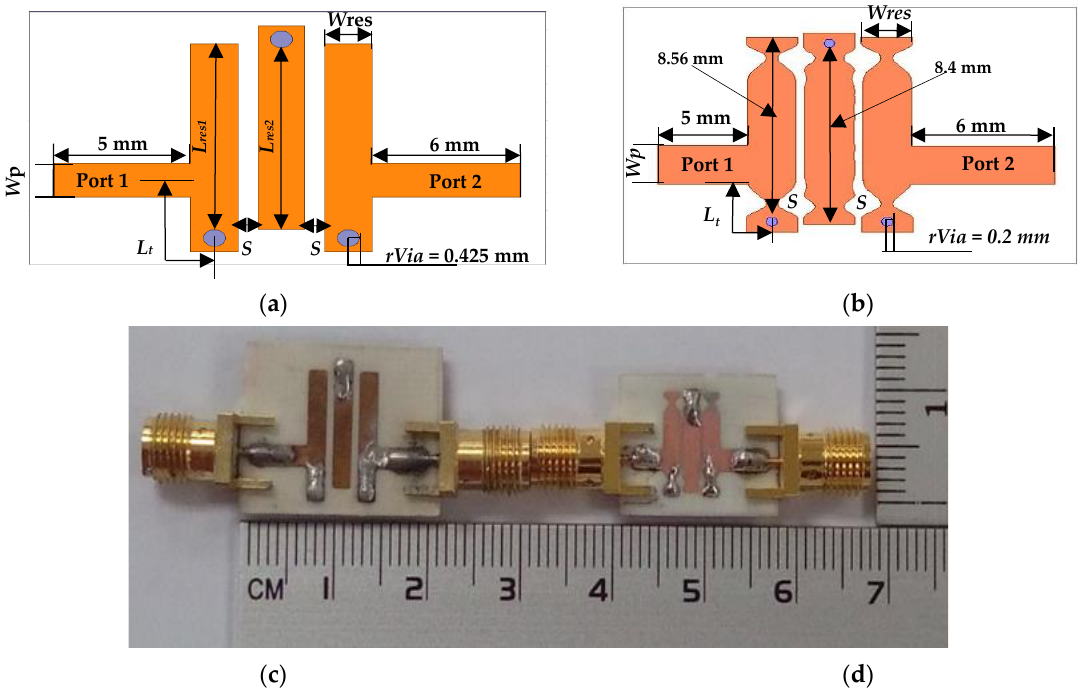
F IGURE 9. (a), (b) 2D configuration and (c), (d) photograph of the proposed (3.7 – 4.2 GHz) UTL and NTL IBPFs, respectively..